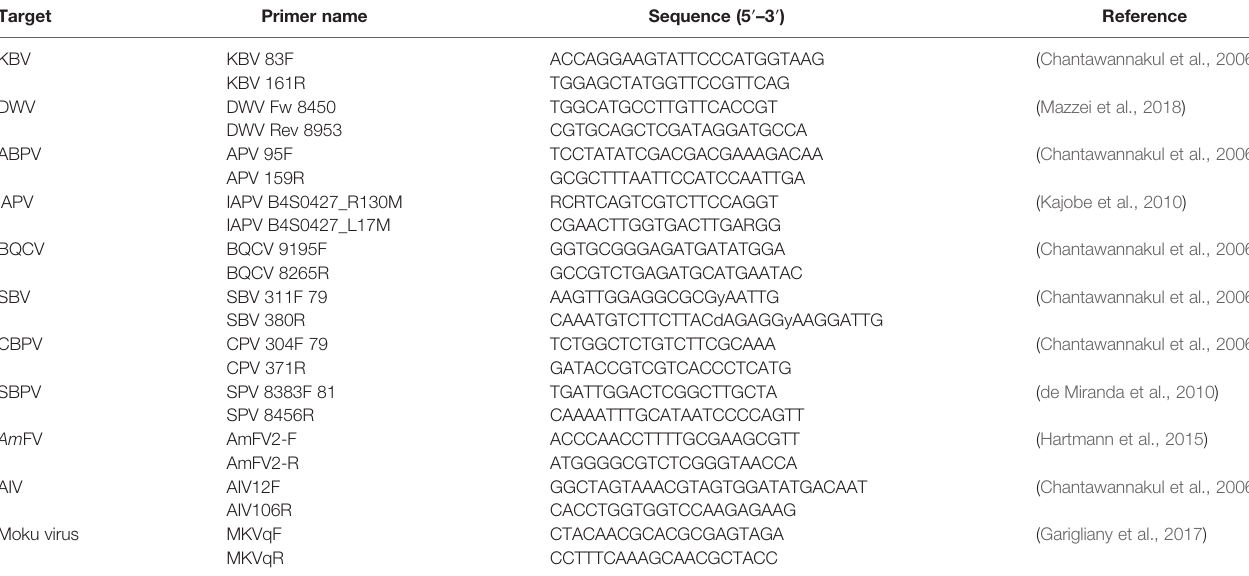
TABLE 3 | List of primers used to detect